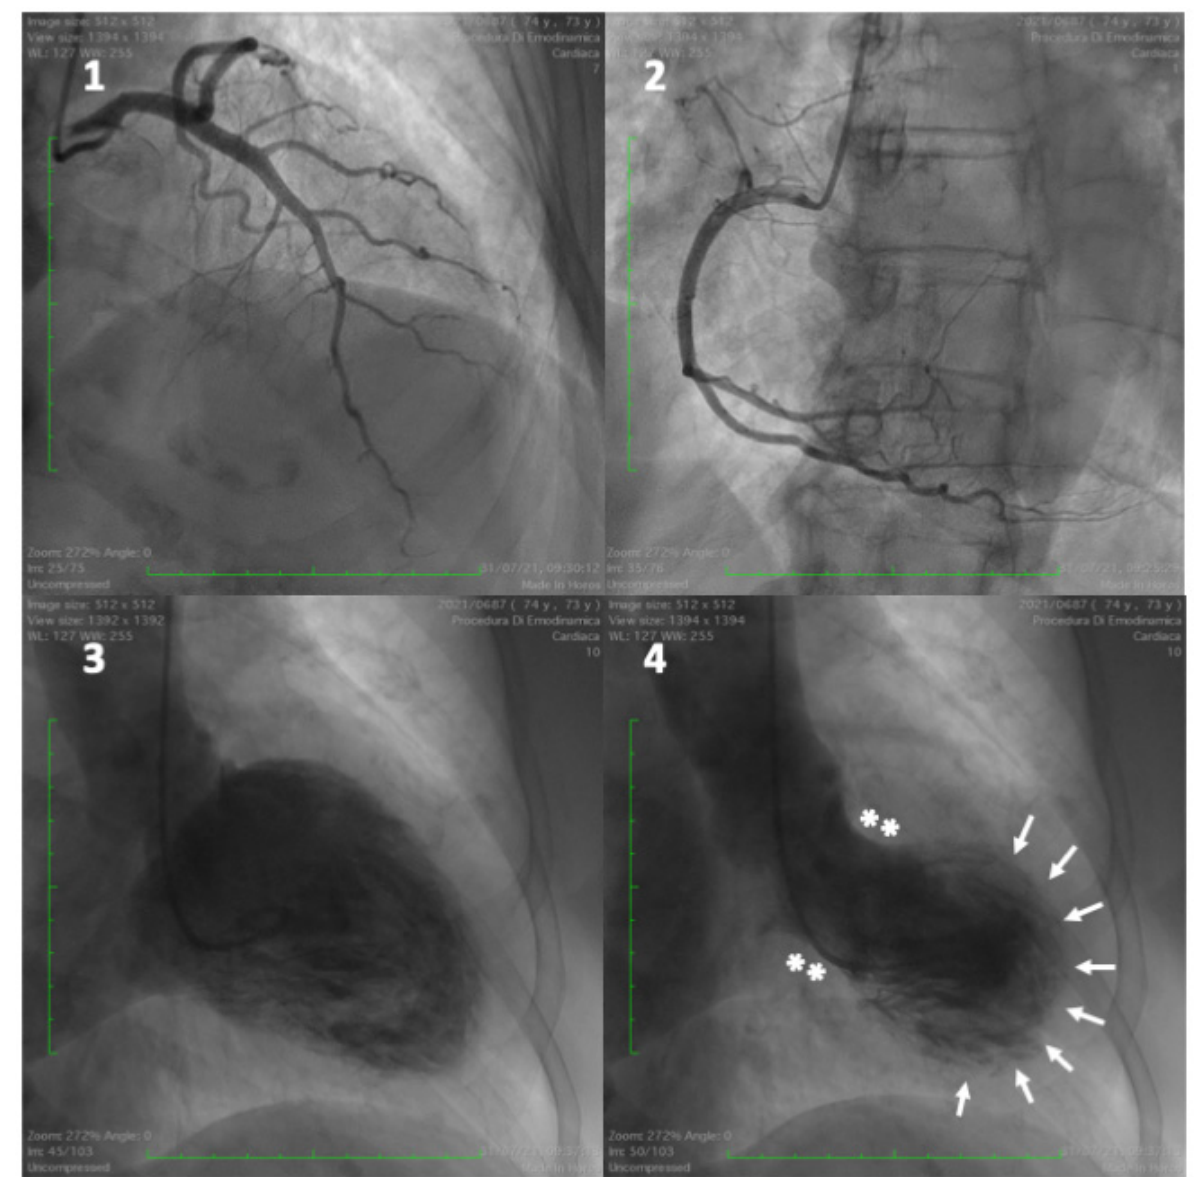
Figure 2. A 73-year-old woman admitted for anterior ST-elevation myocardial infarction. Coronary angiography showed no coronary lesions on left and right coronary arteries (frames ( 1 ) and ( 2 )). Left ventriculogram (frames ( 3 ) and ( 4 )) showed typical ballooning of the left ventricle apex (frame ( 4 )), characterised by hypercontraction of the basal segments (with asterisks) and akinesia in the mid and apical segments (with arrows), typical for Takotsubo cardiomyopathy.